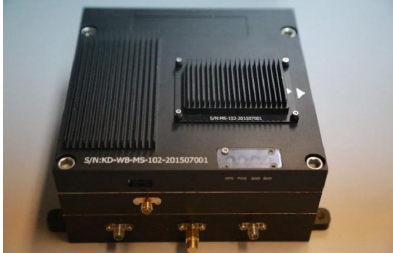
Figure 1. RF and digital subsystems integrated into the